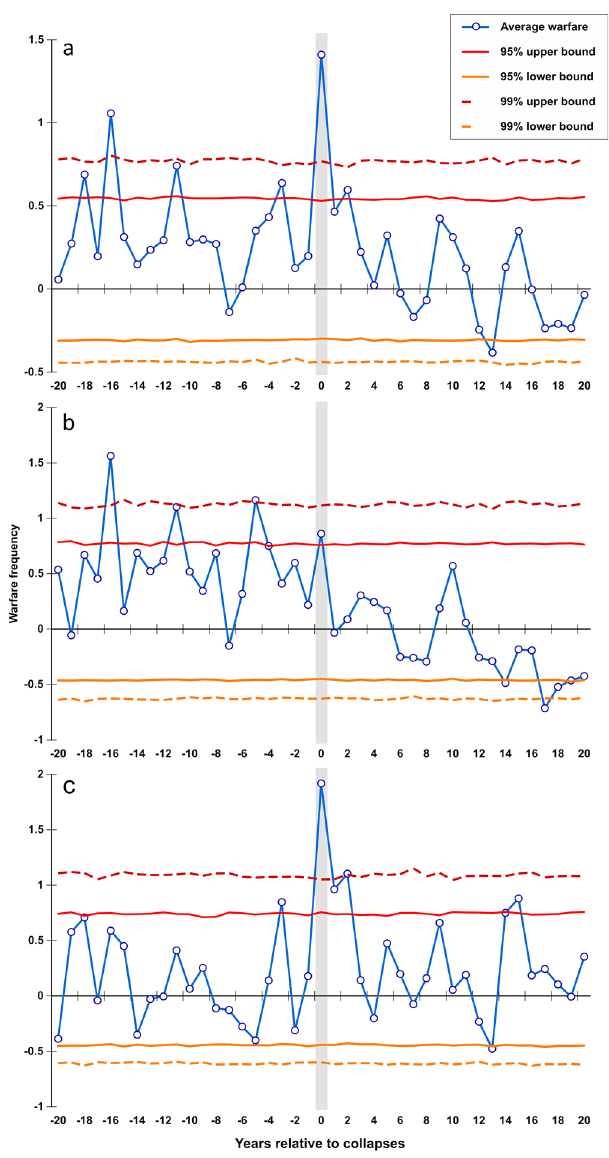
Fig. 3 Annual warfare frequencies relative to Chinese dynastic collapse. a Superposed epoch analysis of annual warfare frequencies 12 relative to all 25 collapses, 850 – 1911 CE (Supplementary Data 1). b Only those collapses with a lesser volcanic association (i.e., having less than the median number of eruptions within the [ − 10, 2] year window relative to the dates of collapse; n = 12 collapses). c Only those collapses with a higher volcanic association (i.e., having more than the median number of eruptions within the [ − 10, 2] year window; n = 13). See Supplementary Table 5. For all panels, warfare data are detrended to remove low-frequency variability and then normalized by setting each annual value relative to the mean and standard deviation of the preceding 30 years (i.e., vertical axis frequencies are expressed in z scores). The horizontal axes cover each of the 20 years before collapse (Points − 20 to − 1), the years of collapse (Point 0), and the following 20 years (Points 1 to 20). Solid and dashed horizontal lines represent the upper and lower 95 and 99% con fi dence bounds, respectively, determined by Monte Carlo resampling (10,000